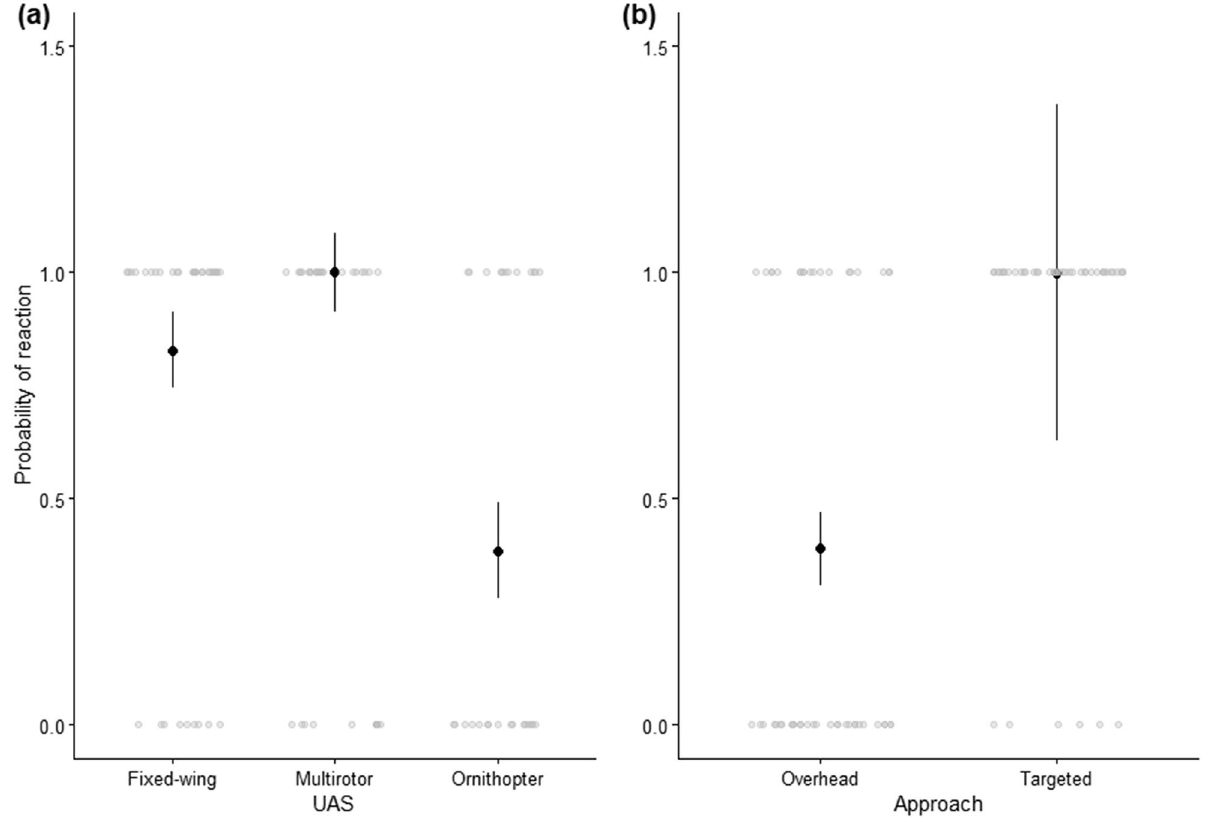
Figure 4. Probability of focal turkey vulture reaction in response to ( a ) UAS platform and ( b ) approach. Raw data are shown as points. UAS trials were conducted at the Erie County Landfill, Ohio, between July and September